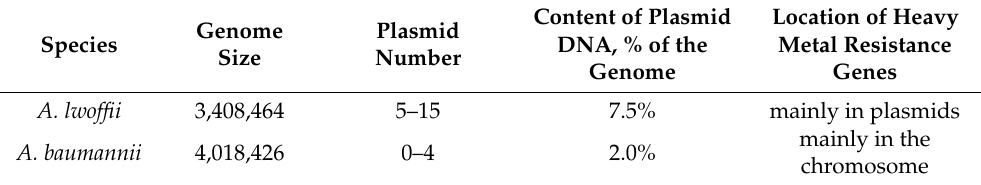
Table 3. Comparative structure of A. lwoffii and A. baumannii genomes [17]. Genome Species Size